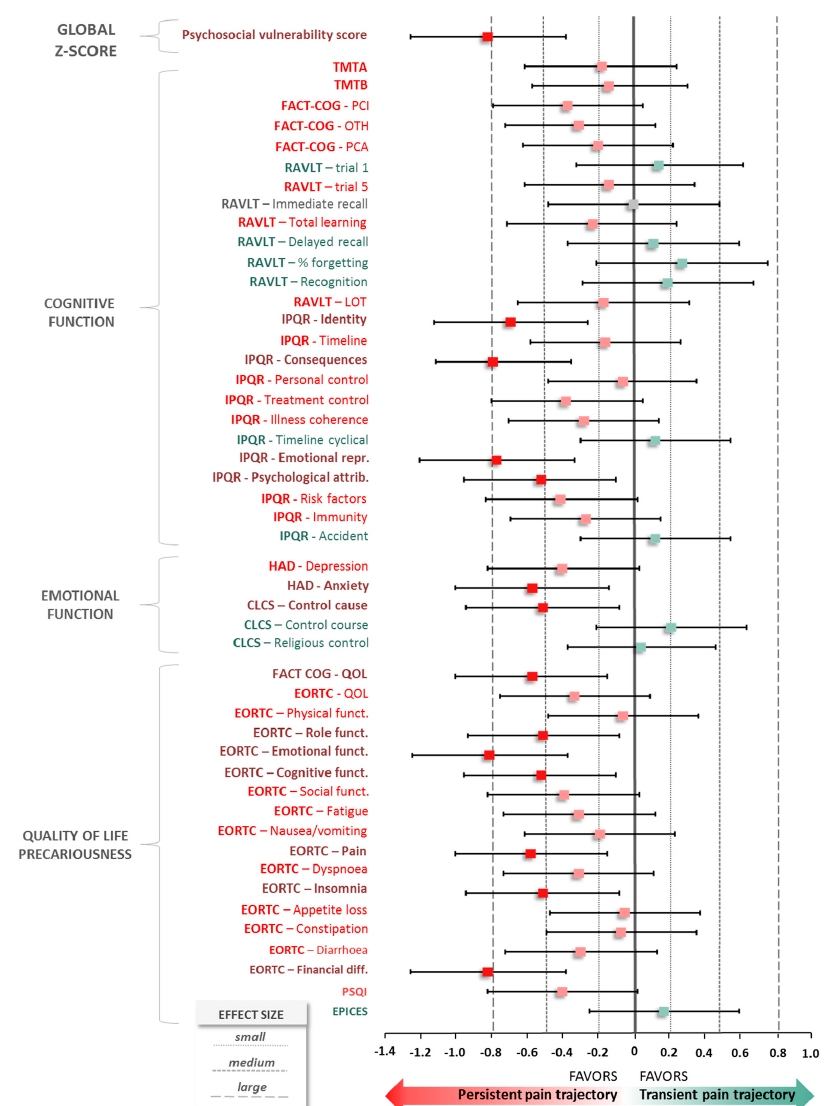
Figure 3. Z-score parameters according to trajectories. Quantitative measure of magnitude of difference of z-score transformation between two pain trajectories: Persistent Pain trajectory (PP) vs. Transient Pain trajectory (TP) and psychosocial vulnerability score. Effect size was calculated as the difference between means of each trajectory divided by standard-deviation, i.e., m 1 − m 2 with m 1 and m 2 the means for each trajectory group, n 1 and n 2 the sample sizes and s 1 and s 2 the standard-deviations. A negative e ff ect size is indicative of a positive psychosocial vulnerability score (the patient is better), whilst a positive e ff ect size is indicative of a negative psychosocial vulnerability